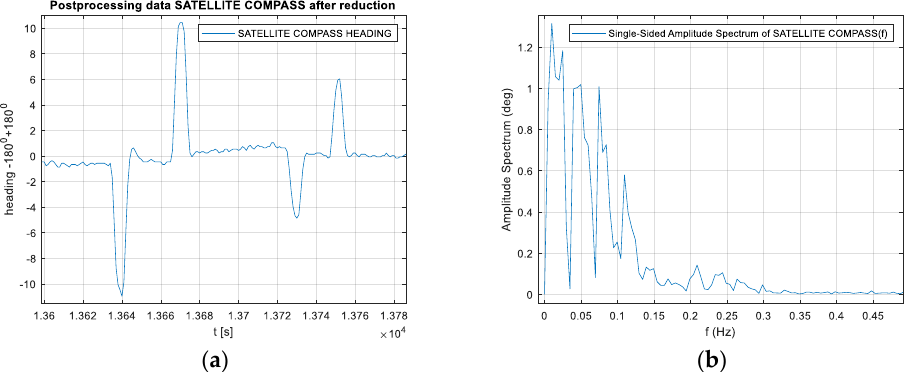
Figure 22. Heading distortions from 00:25:17 UTC to 00:30:37 UTC ( a ) and a frequency spectrum of heading changes ( b ).